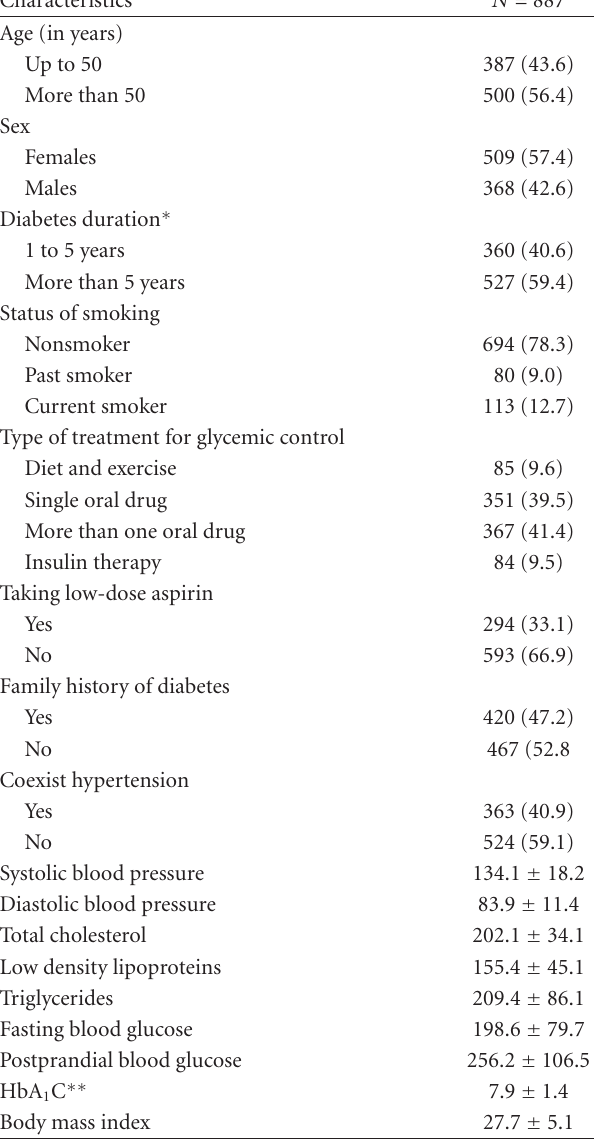
Table 1: Background characteristics of study